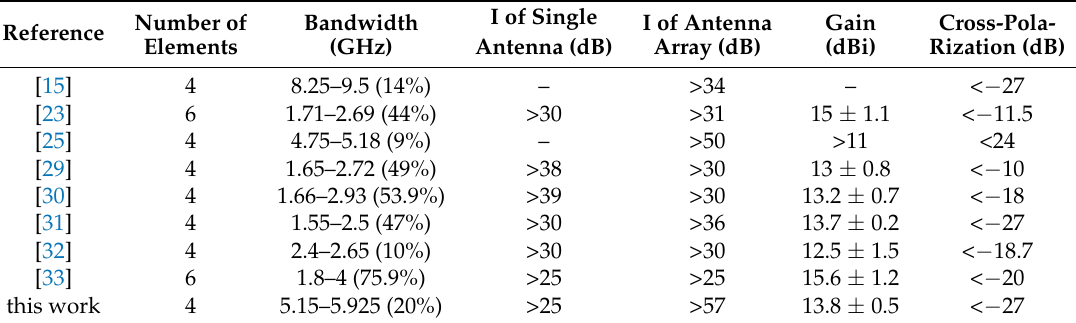
Table 3. Comparison of the proposed and reference